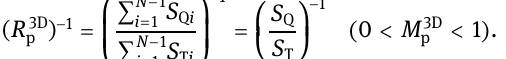
damaged, and this results in a sliding type after climbing over the convex body.